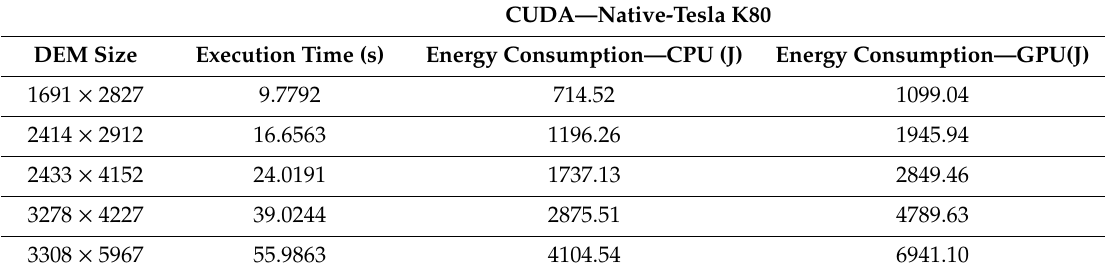
Table 8. CUDA—native-Tesla K80.